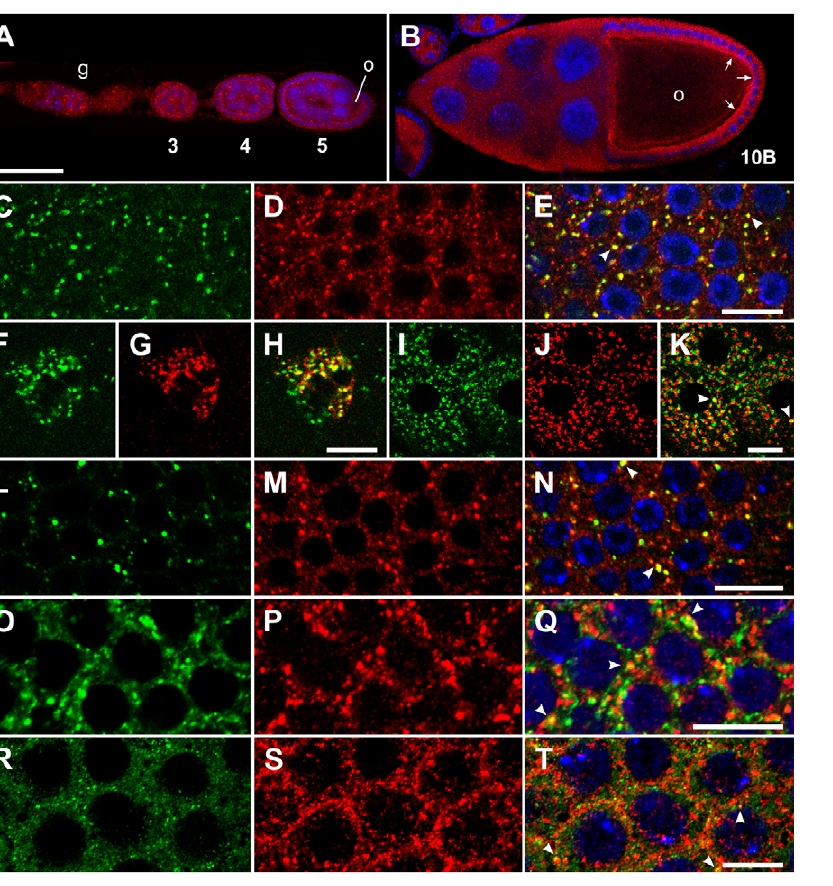
Figure 2. Liquid facets-Related is found throughout the ovariole and colocalizes with Golgi, clathrin and some endosome markers. (A,B) LqfR (red) is expressed in punctae in the germarium (g), in the oocyte (o), nurse cells, and in the surrounding follicle cells during oogenesis in wild type ovaries. LqfR is enriched apically (arrows) in follicle cells beginning around mid-oogenesis as is evident at stage 10B, but is much weaker in the oocyte than in surrounding tissue at this stage. Anterior is to the left and stages are indicated. (C–T) Colocalization of LqfR (red) with various markers (green). (C–E) TGN-localized anti-syntaxin16 [26] in follicle cells from a stage 9 egg chamber. medial-Golgi-localized anti-p120 [45] in migrating border cells (F–H) and in follicle cells from a stage 14 egg chamber (I–K). (L–N) Clathrin light chain-GFP [46], and (O–Q) the early endosome marker Rab5-GFP [47] in follicle cells of stage 9 egg chambers. (R–T) MVP marker anti-Hrs [48] in follicle cells from a stage 10B egg chamber. Some punctae of colocalization are indicated by arrowheads (E,K,N,Q,T). Egg chambers in (C–K, R–T) are from females of genotype hsFLP/ + ; FRT-82B lqfR D66 / FRT-82B ovoD1-18 . For (L–Q), expression of the GFP-fusion proteins is driven by TubulinP-Gal4 [49] in a wild type background. Panels on the right (E,H,K,N,Q,T) are merges of the adjacent left two panels and also show To-Pro-3 stained nuclei in blue (except E and H). All images are single confocal slices. Bar, 50 m m (A,B) and 10 m m (C–T).